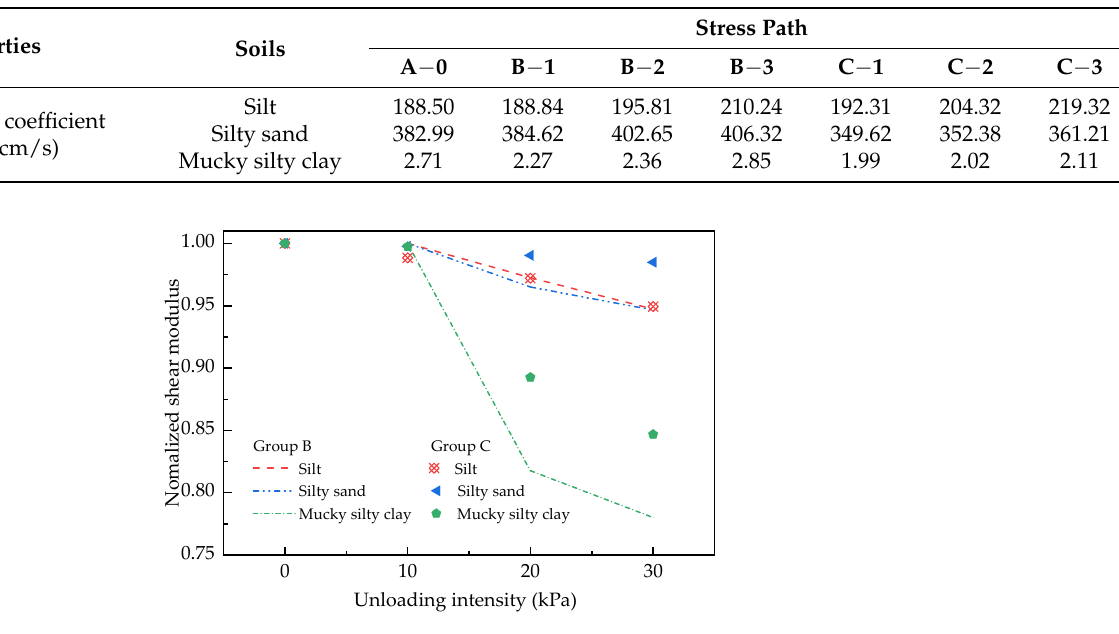
Table 8. Permeability coefficient of soil.